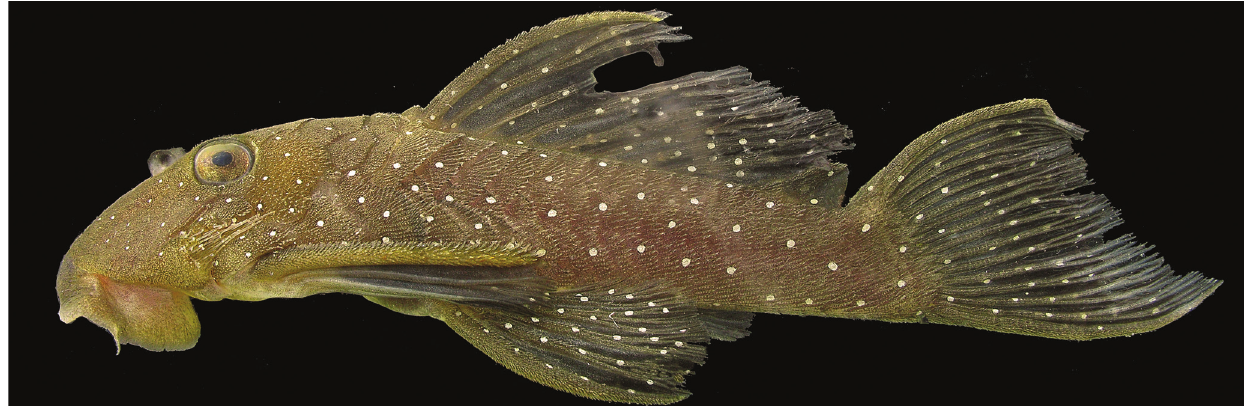
Fig. 7. Color in live of Spectracanthicus punctatissimus . Image by J. Birindelli. anterior margin of coracoid. Medial end of premaxillary teeth series curved inwards. Premaxillae and dentaries narrow and elongate. Dentaries strongly curved inwards. Teeth